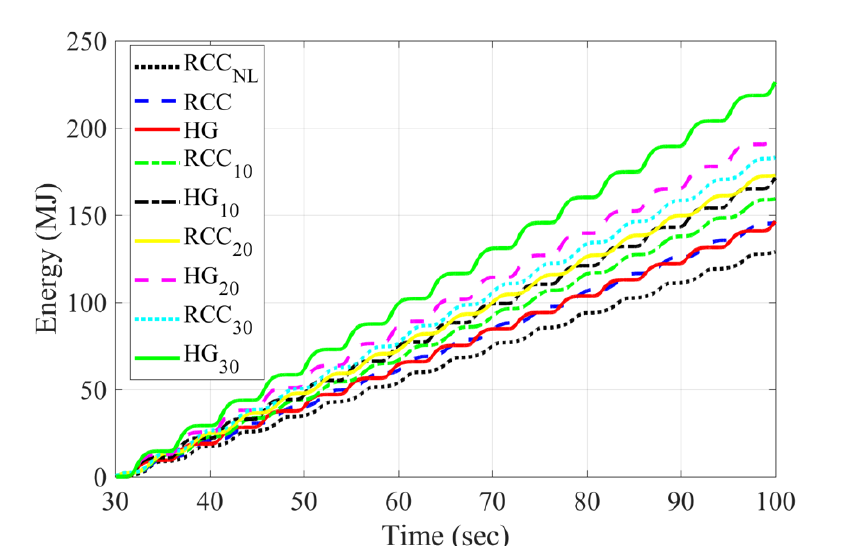
Figure 11. Harvested energy for all